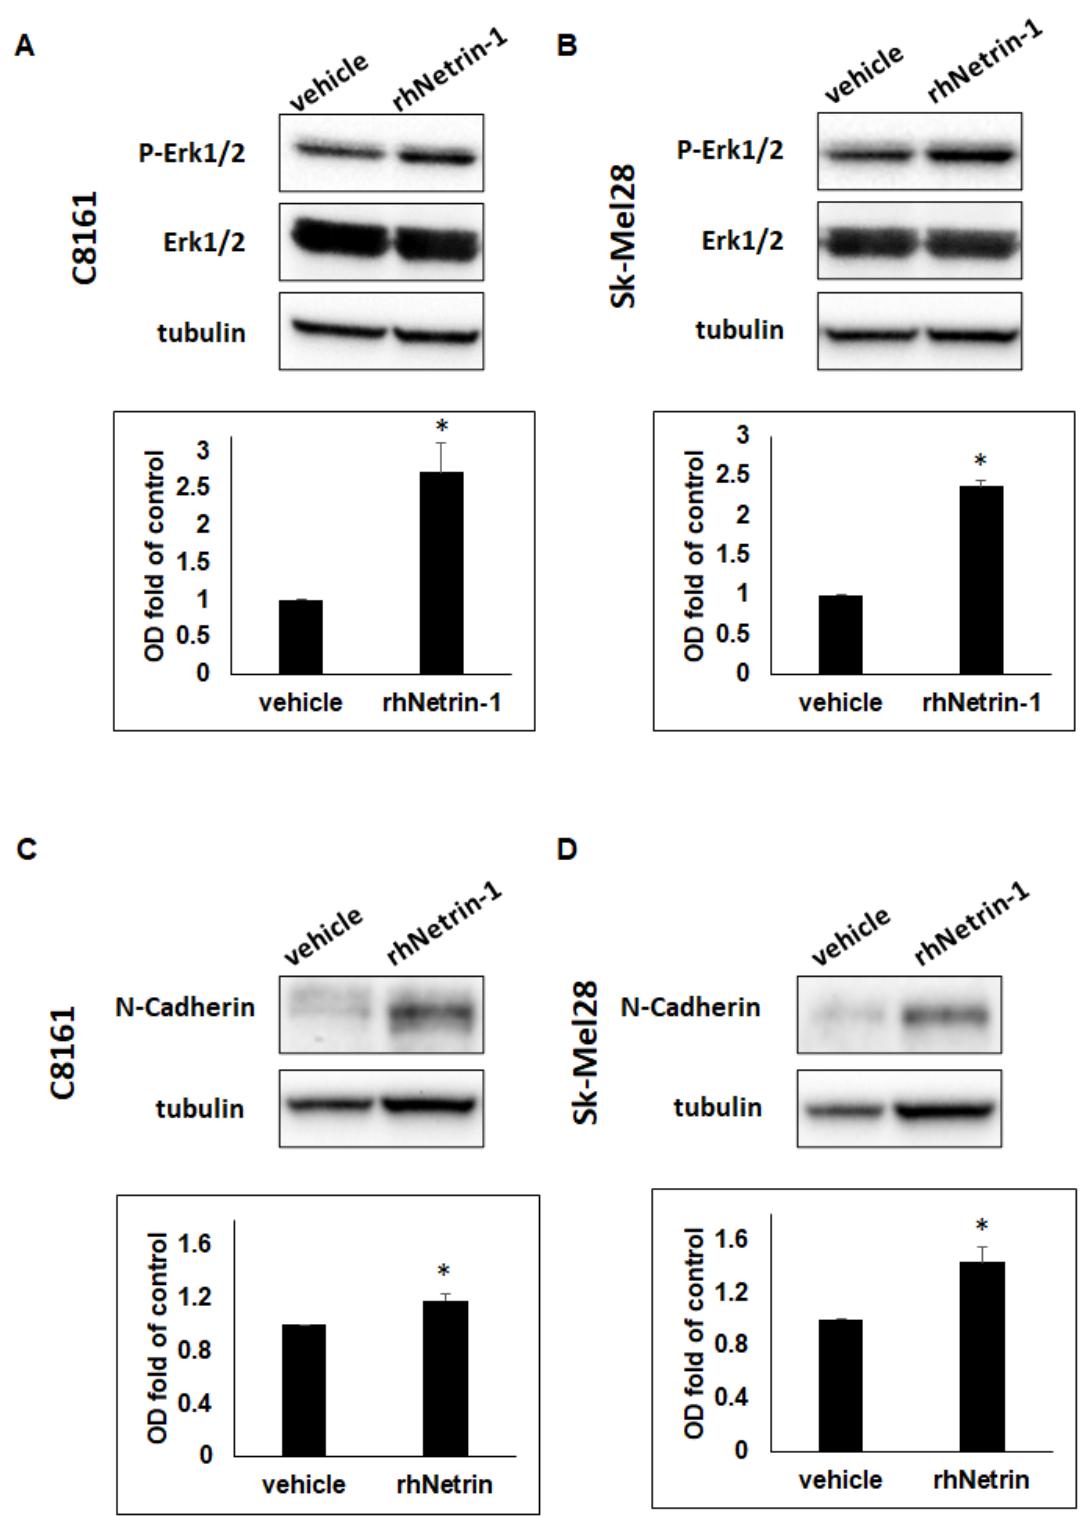
Figure 3. Netrin-1 stimulates pERK1/2 activation and N-cadherin expression in aggressive melanoma cells. Results from WB show significantly increased expression of P-ERK1/2 ( A , B ) and N-cadherin ( C , D ) in C8161 ( n = 3) and Sk-Mel28 ( n = 3) aggressive melanoma cells treated with 200 ng/mL of exogenous, soluble rhNetrin-1, compared to vehicle control (* p < 0.05).